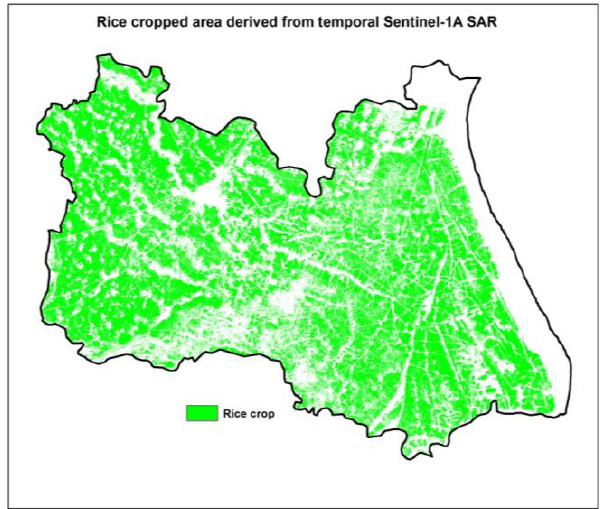
Figure.4. Classified map of rice cropped from Sentinel-1A SAR data